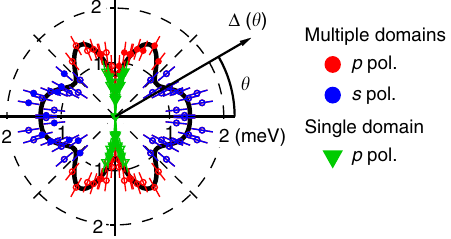
Fig. 4 Superconducting gap anisotropy of the elliptical Fermi surface. Results of the multi-domain sample with p - (red circle) and s - (blue circle) polarized light are shown together, considering that each polarization predominantly probes different domains. Results of the single-domain sample (green triangle) are also shown together. Solid symbols are obtained from BCS spectra fi tting and open symbols are symmetrized by taking into account the orthorhombic crystal symmetry. Error bars are determined by the systematic and statistical error of the calibrated E F positions, as explained in Supplementary Note 8. The black curve is fi tting to the observed anisotropy of the multi-domain sample, considering the twofold orthorhombic symmetry. The fi tting function is Δ ð θ Þ ¼ j A þ B cos ð 2 θ Þ þ C cos ð 4 θ Þ þ D cos ð 6 θ Þ þ E cos ð 8 θ